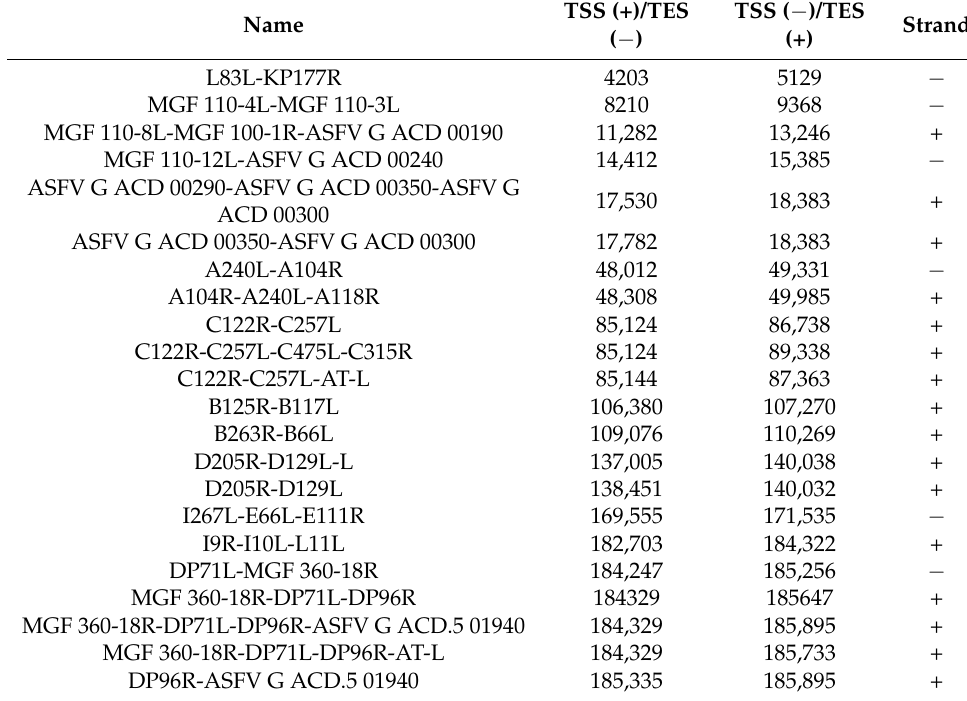
Table 5. List of the complex